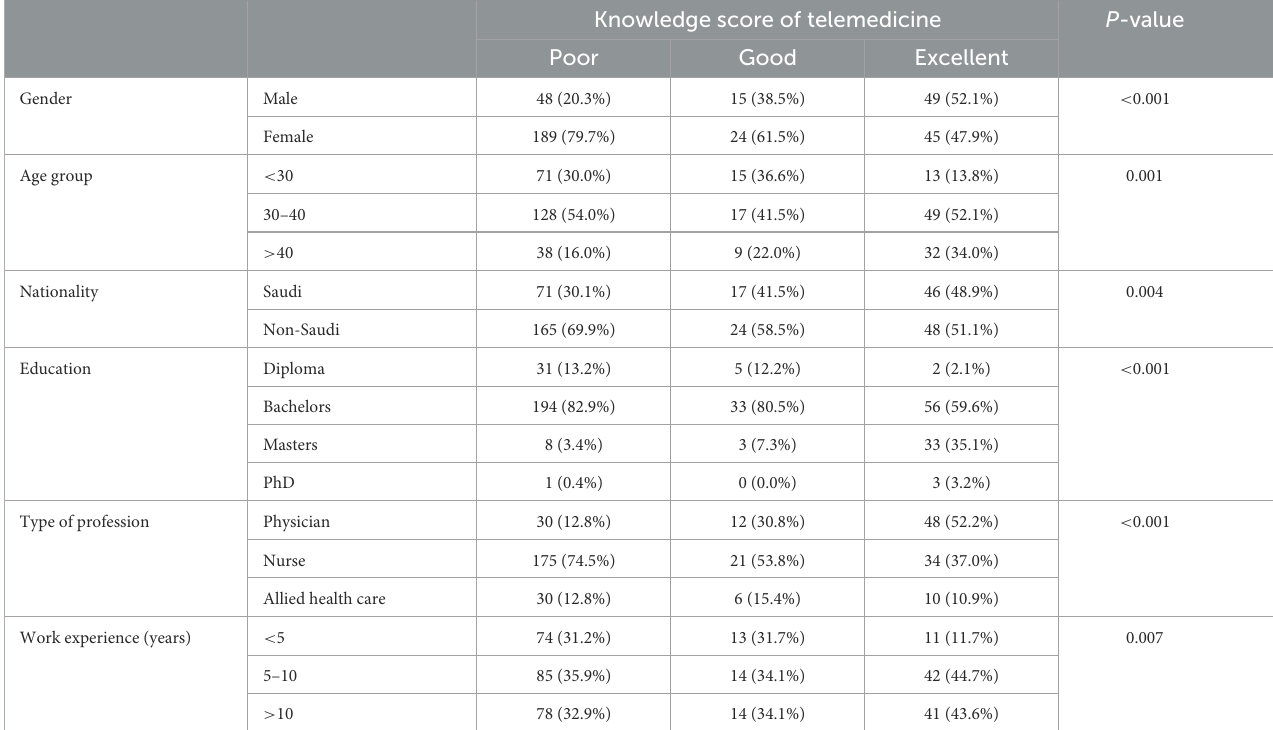
TABLE 2 Impact and association between knowledge score of telemedicine and study factors.